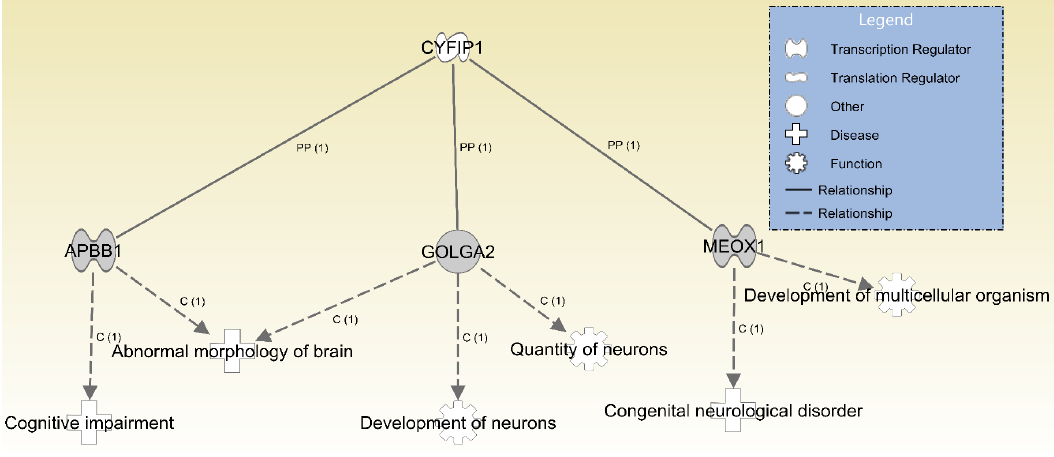
Figure 3. Genes with de novo variants with evidence for downstream relationships with CYFIP1 . Shown are three genes prioritized following Ingenuity Pathway Analysis of all genes with de novo variants in affected children that were evidenced to be involved in the etiology of diseases relevant to symptoms observed in affected children. Included are protein–protein interactions (PP) and diseases and functions where variation in the gene is causal (C).